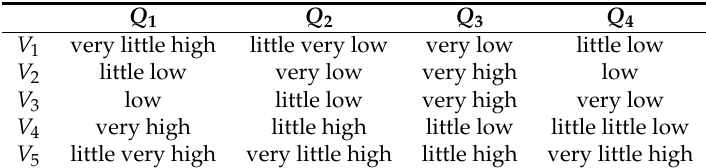
Table 3. Scales in sensibilities of decision makers on the objective function.